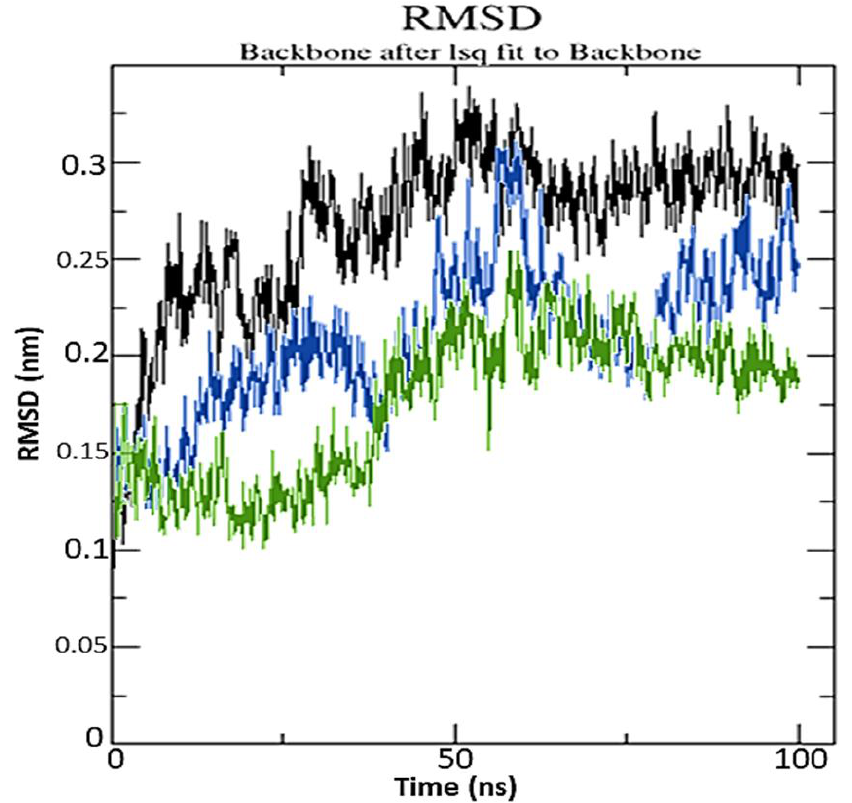
Figure 11. Root mean square deviation of solvated receptor backbone and ligand complex during the 100 ns molecular dynamics simulation: RisS complex (blue) and CTcS complex (green), and unbound serotonin receptor (black).